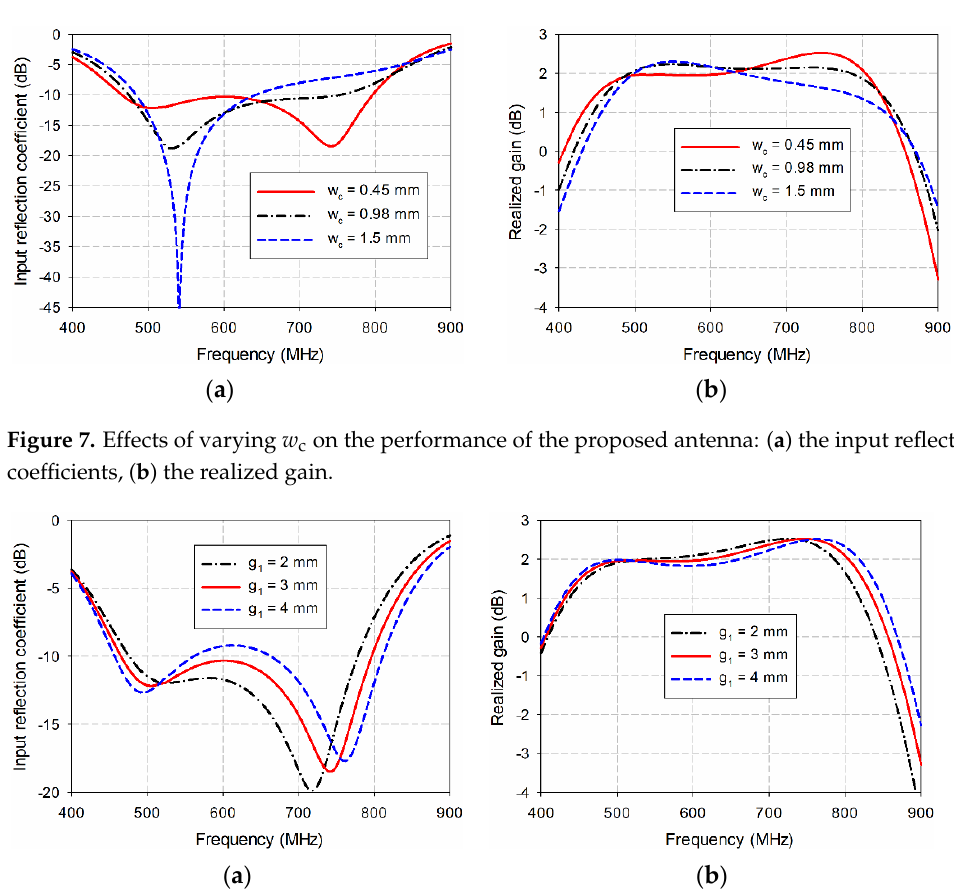
Figure 8. Effects of varying g 1 on the performance of the proposed antenna: ( a ) the input reflection coefficients; ( b ) the realized gain.